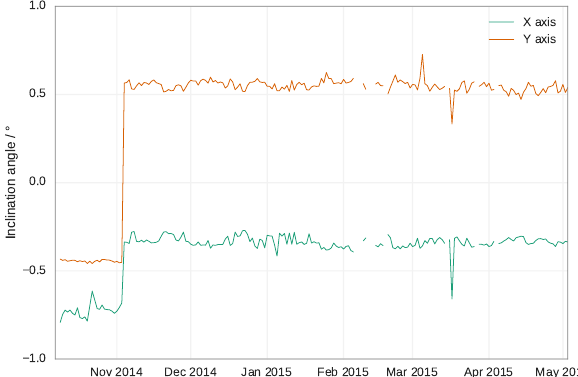
Figure 6. Evolution of the inclination of the laser over the season at Col de